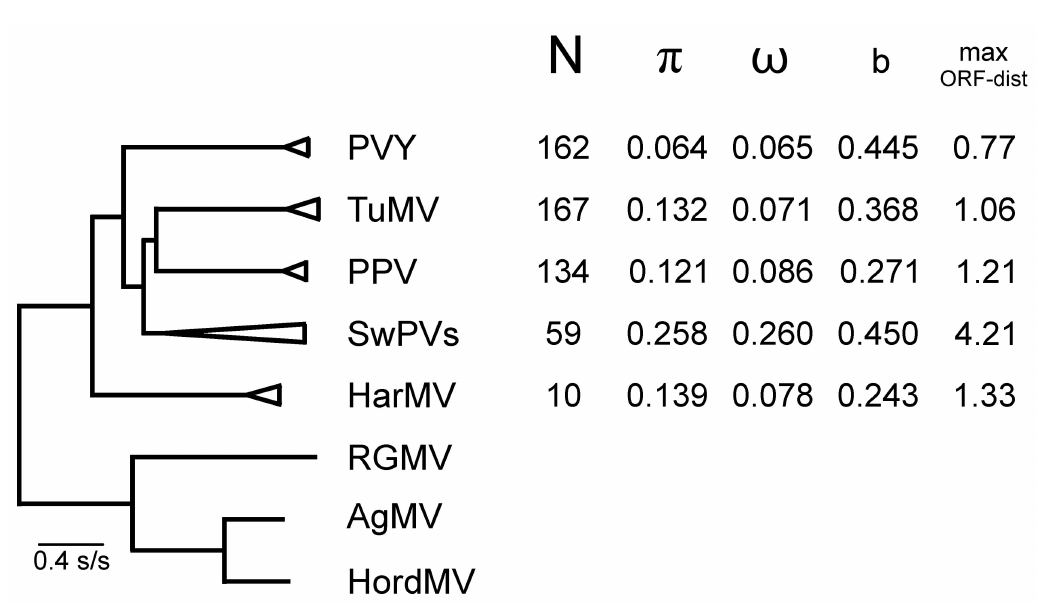
Figure 5. The ML phylogenetic tree (collapsed) of the non-recombinant (n-rec) ORFs of five potyvirus populations. The number of ORF sequences for each virus (N), their average pairwise nt diversity ( π ) and, for each, the ratio of nonsynonymous nt diversity to synonymous nt diversity ω (dN / dS); also the slope (b) of the linear regression in a graph comparing the pairwise patristic distances in ML trees of the ORF sequences ( y axis) and encoded polyproteins ( x axis), and the maximum patristic distance (max ORF-dist) in the patristic distance